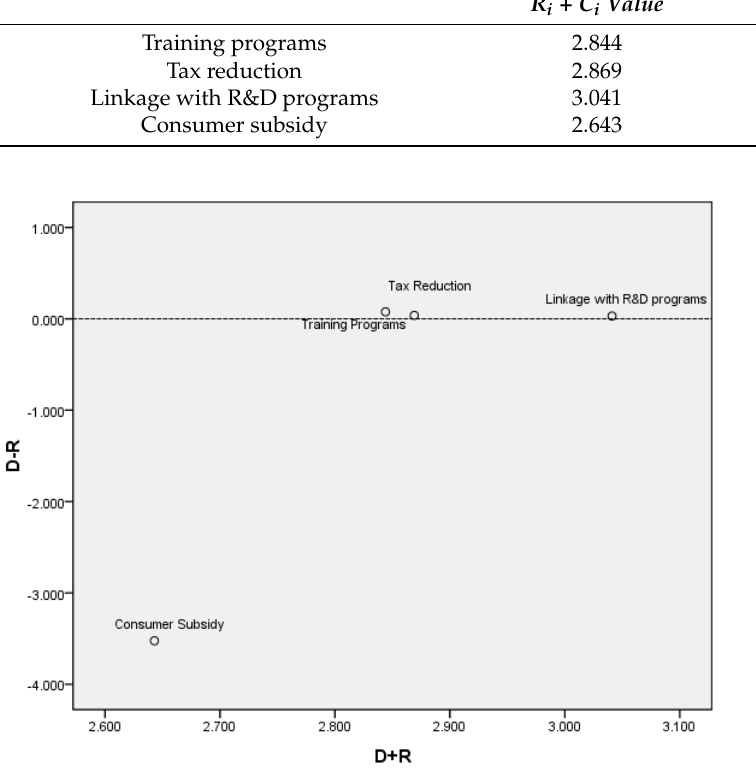
Figure 5. Graph of appearing causal relationship of the government policy criteria.